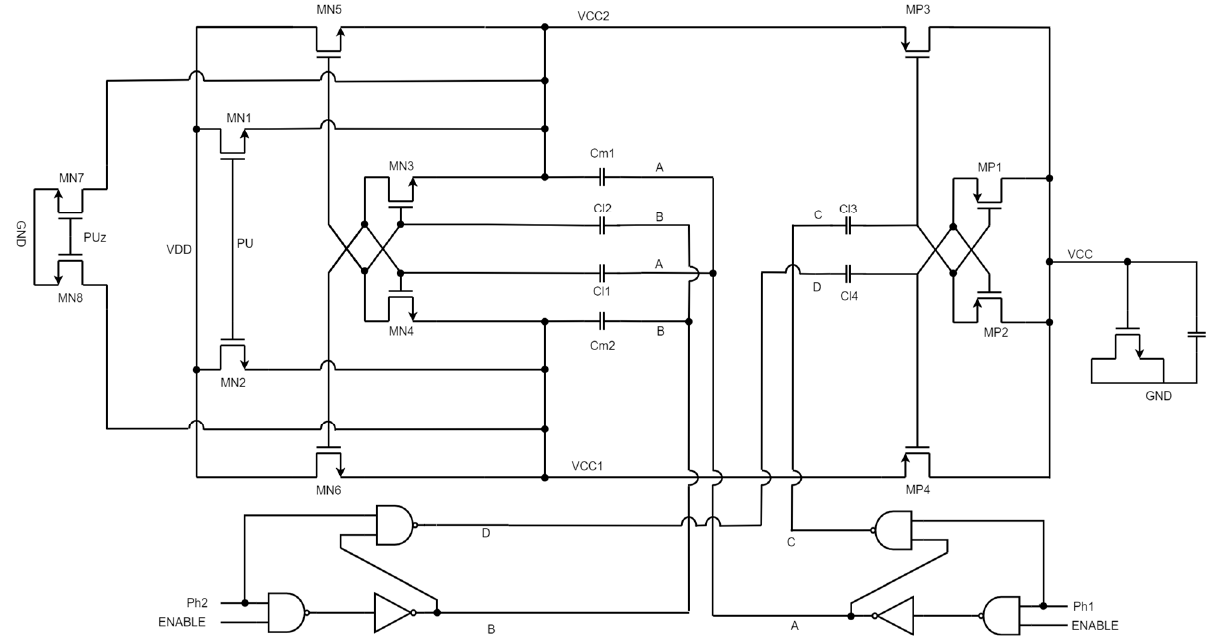
Figure 3. Differential charge